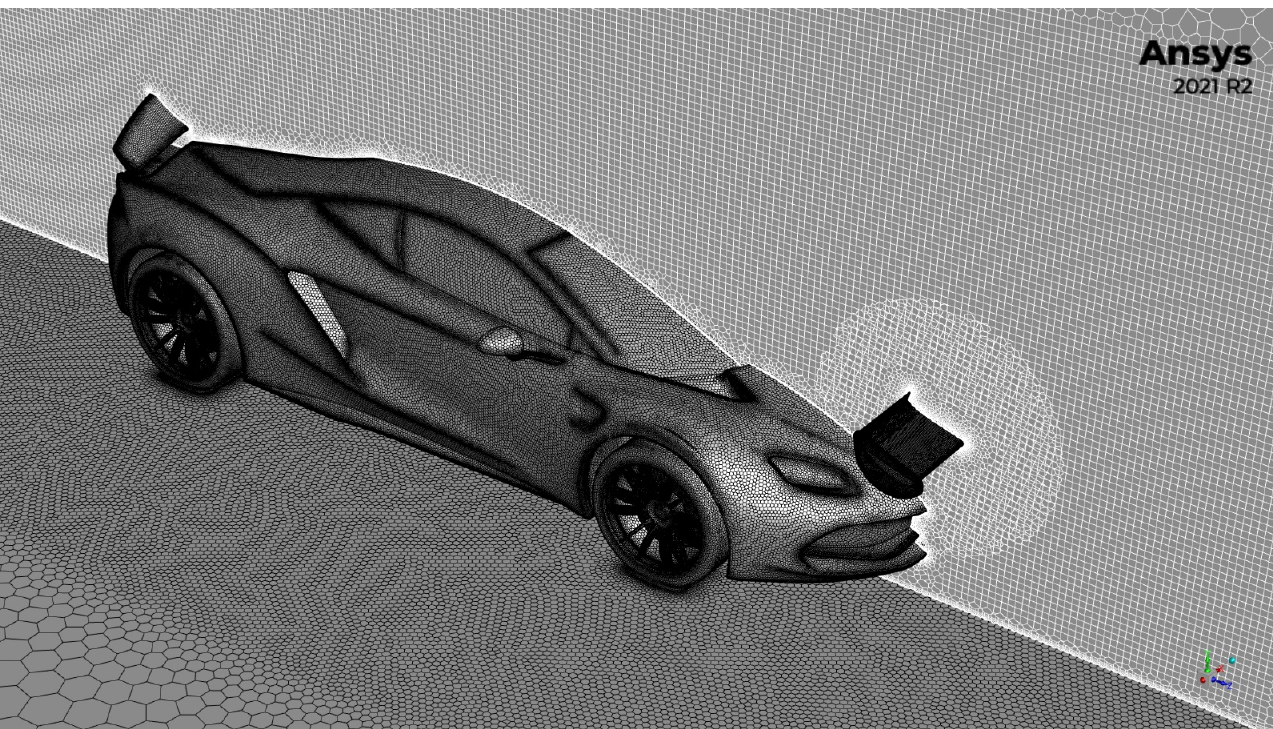
Figure 11. Mesh selected in the grid independence study: medium body of influence size and medium mesh density.